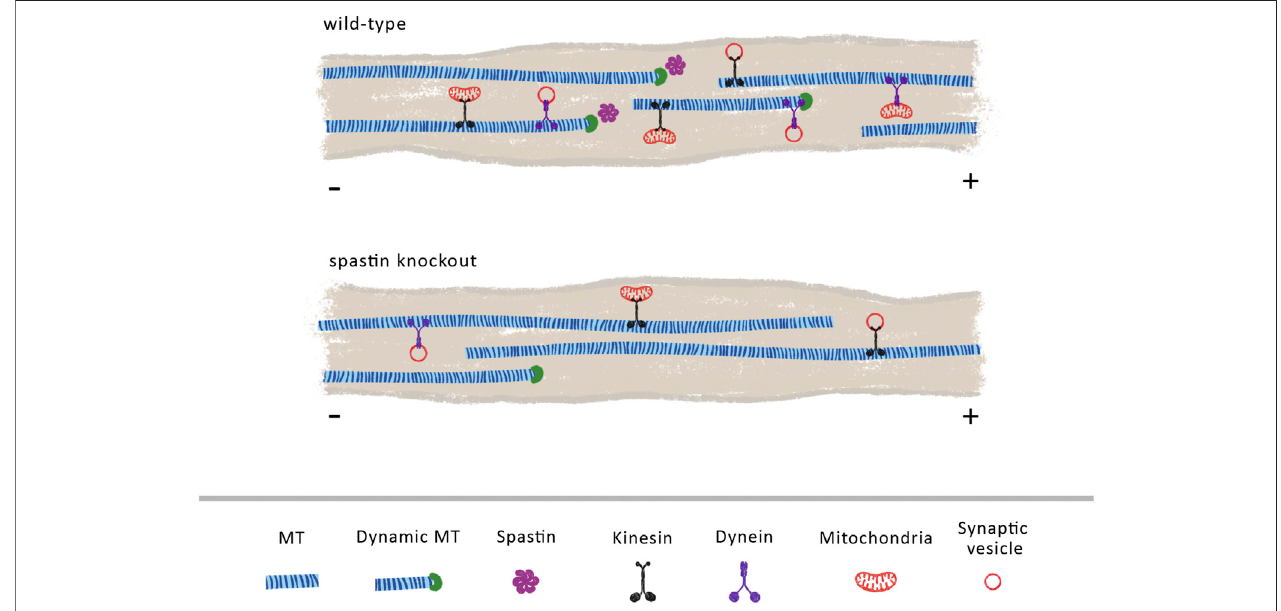
FIGURE2| SpastinplaysavitalroleinregulatingMTcytoskeletondensityanddynamics.Weproposethatinwild-typeanimals,endogenousspastincontributesto themaintenanceofadynamicanddenseMTcytoskeletonthatsustainsanef fi cientaxonaltransport.ItsactivitymayincreasethenumberofdynamicMTs,facilitatingthe loading of retrograde cargoes mediated through dynein motors. In the absence of spastin, the density and dynamics of MTs is reduced, due to a decline in the levels of MT severing and MT nucleation, decreasing the overall axonal transport.